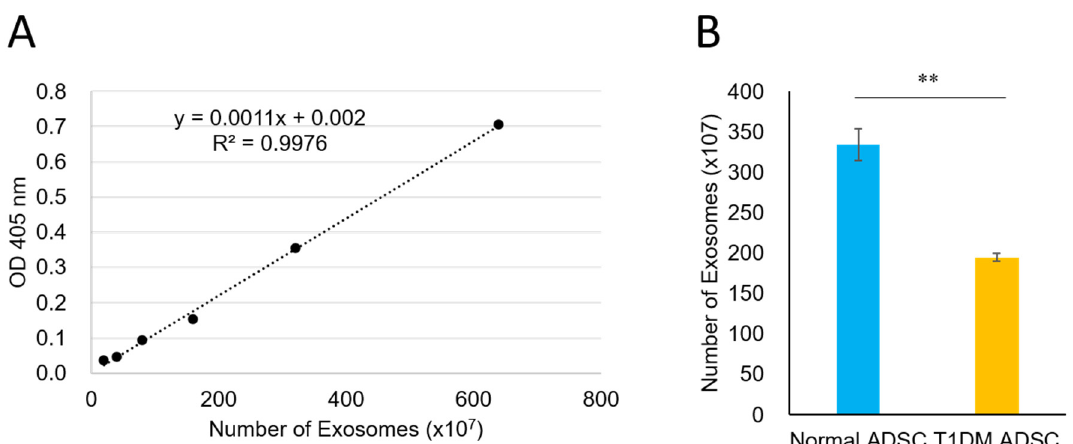
Figure 5. Quantification of exosomes for adipose-derived stem cells of patients with type 1 diabetes mellitus (T1DM ADSC). Results of quantification of exosomes extracted from adipose-derived mesenchymal stem cells (ADSCs) by colorimetry using acetylcholinesterase (AChE) activity as an index. ( A ) A standard curve created with two-fold serial dilutions of an exosome AChE standard. ( B ) A graph showing exosome counts calculated using the standard curve obtained from absorbance values measured at 405 nm by colorimetry; the exosomes were collected from the same volume of normal and T1DM ADSCs culture supernatants. Values shown in the graph are in the form of mean ± SEM. The number of samples is n = 3. Three independent evaluations were performed. Shapiro–Wilk and unpaired t -tests were used for statistical analysis. ** The p -value was 0.0023.